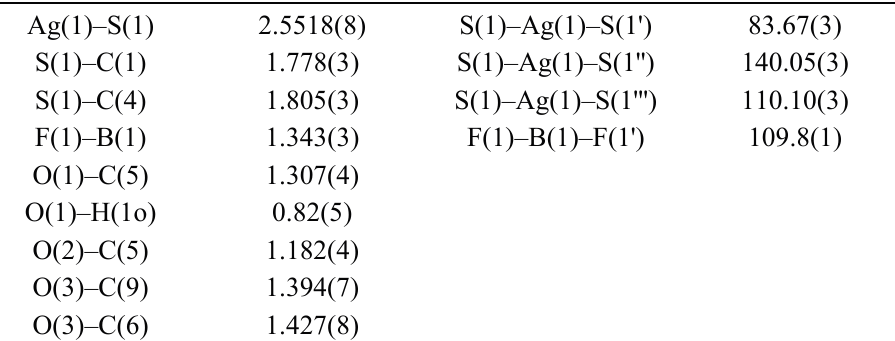
Table 1. Selected bond lengths (Å) and angles (°) in 1